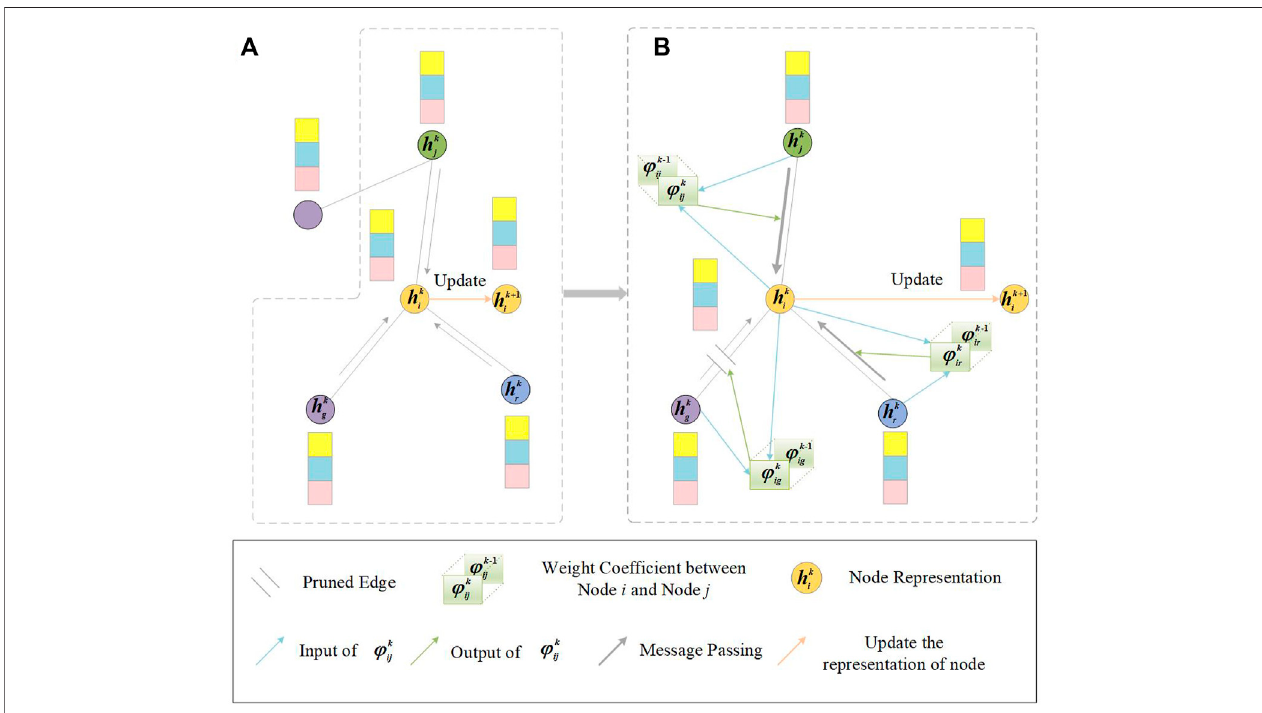
FIGURE 2 | Illustration of GNNGUARD. An example of one node (orange node) is chosen to demonstrate the process of layer-wise graph memory. (A) Message passing in i ’ s local neighborhood in the k -th layer of GCN. (B) Thickness of the gray arrow represents the weight in the message passing of GCN. The weight between node i and node j is utilized to determine message passing between nodes, such as strengthening message or blocking message. To stably train model, the k -th layer weight coef fi cient keeps a partial memory of the k − 1-th